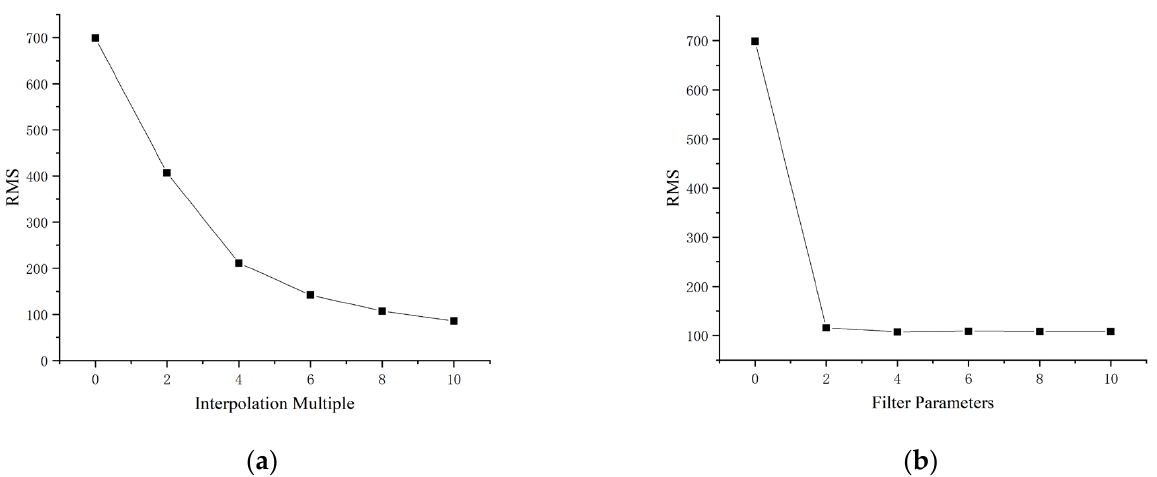
Figure 8. ( a ) RMS values corresponding to different sinc interpolation multipliers, using default filter parameters; ( b ) RMS values corresponding to different filter parameters for a sinc interpolation multiplier of 8.